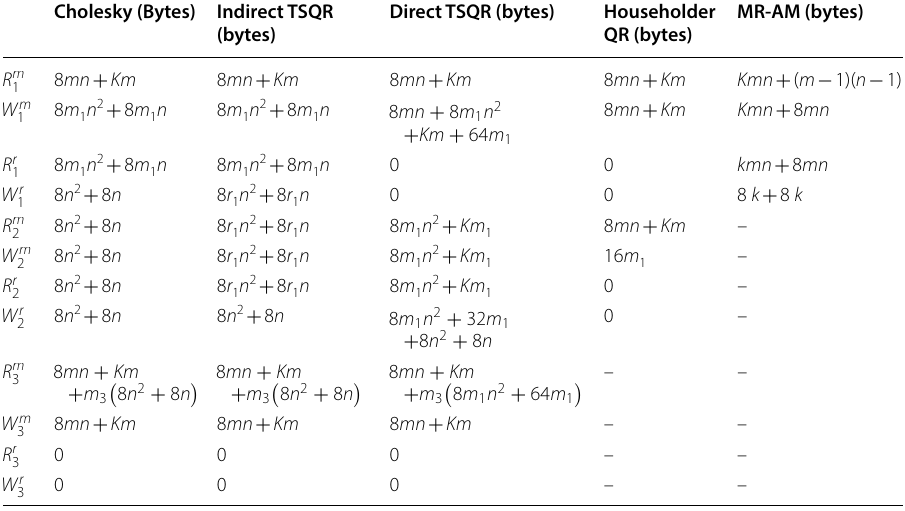
Table 2 Number of reads and writes at each step (in